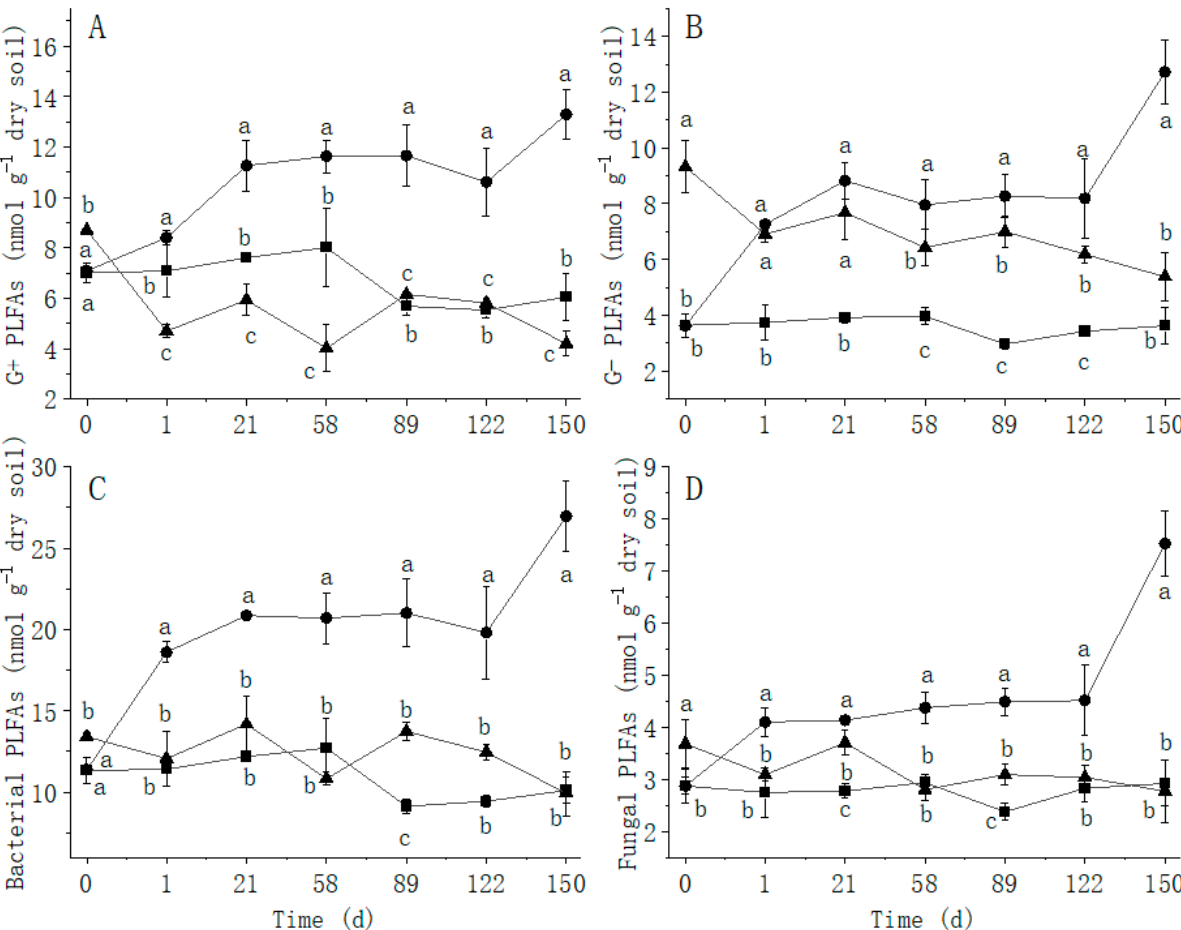
Figure 6. Soil PLFAs under different atrazine application treatments. Data represent the mean ± SD of each soil sample selected at each time-point. ( A ) Gram-positive bacterium (G+); ( B ) Gram-negative bacterium (G-); ( C ) bacterial; ( D ) fungal.